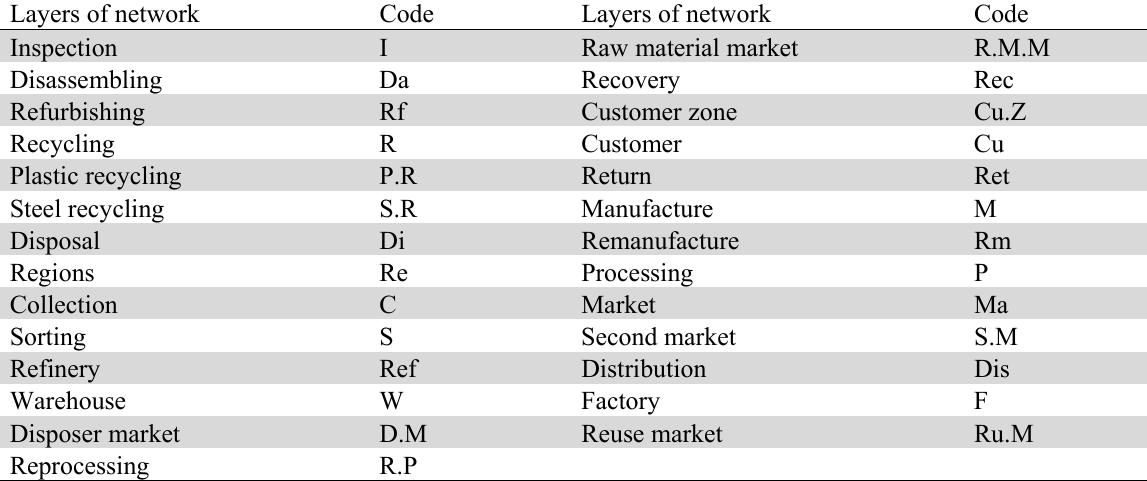
Network structure